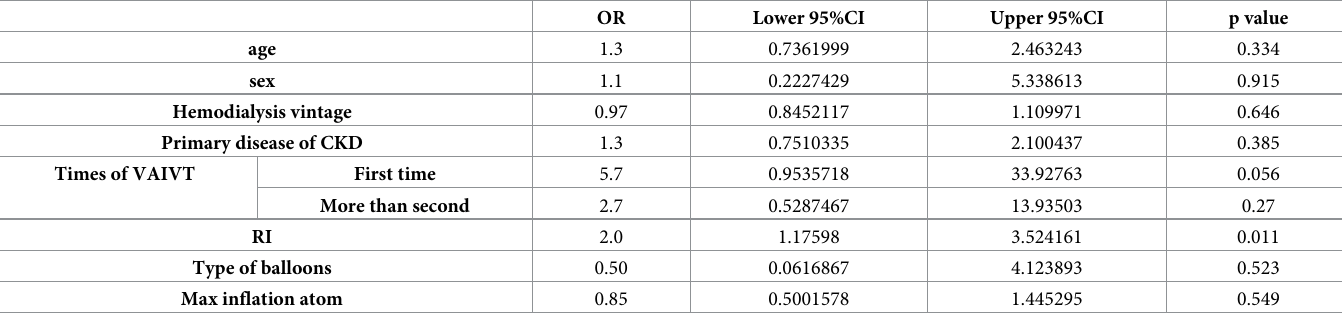
Table 4. Predictors of rupture based on multivariate logistic regression analysis. (AVFonly). OR Lower 95%CI Upper 95%CI p value age 1.3 0.7361999 2.463243 0.334